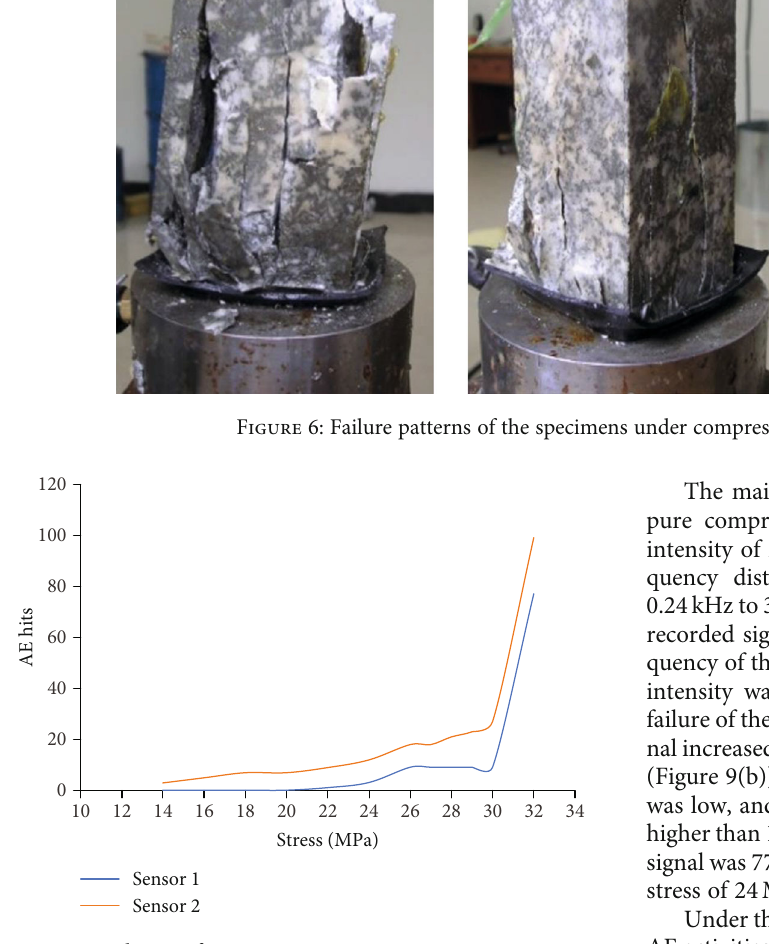
Figure 7: Evolution of acoustic activities in pure compression tests.